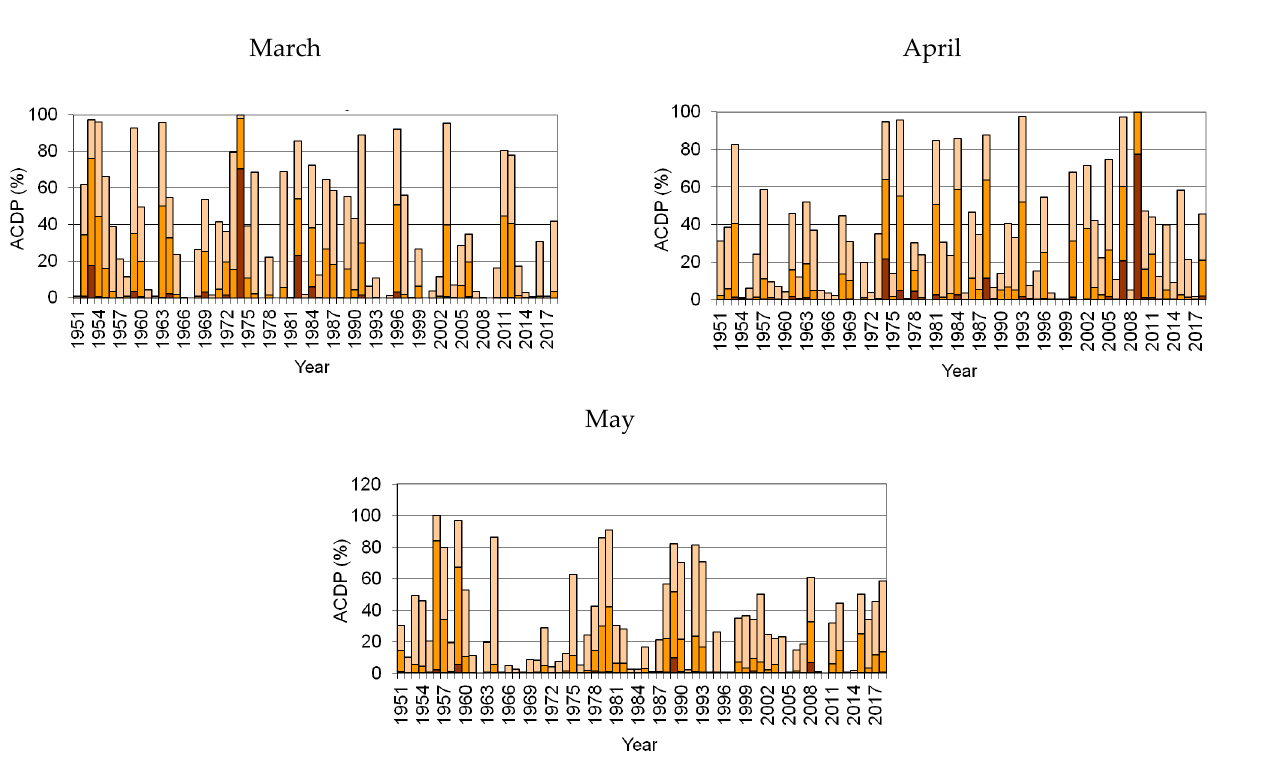
Figure 9. Area of the country affected by deficient precipitation (ACDP) by months of different intensity: high ( ), medium ( ) and low ( ). Years 1951 – 2018.